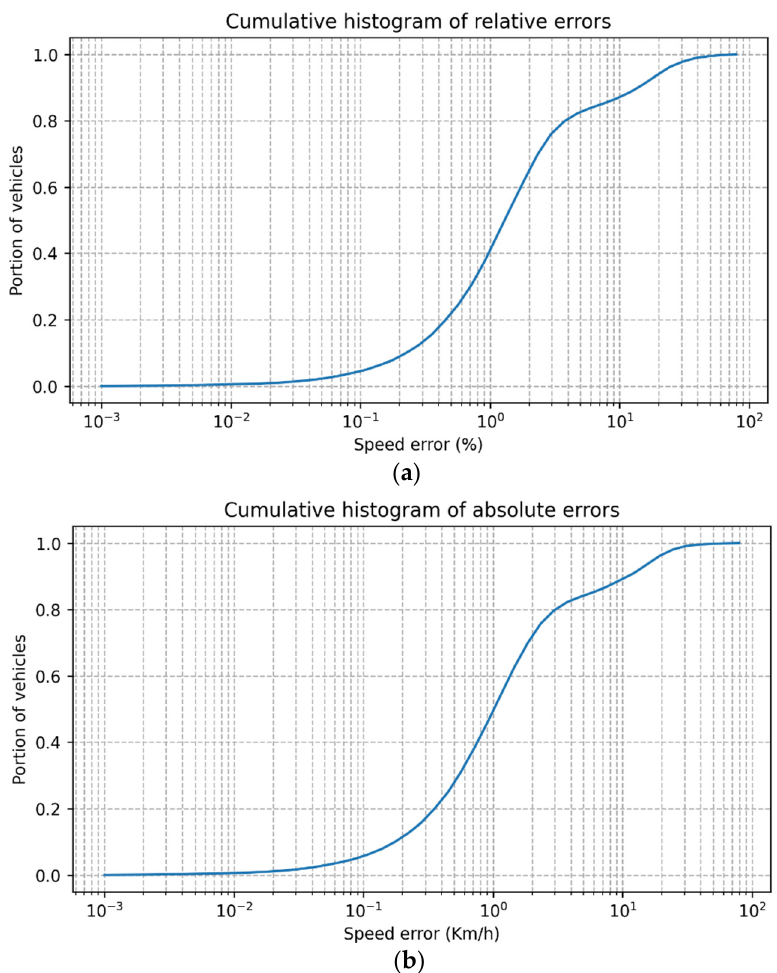
Figure 5. Cumulative histograms that show the distribution of the speed error (logarithmic scale) when compared to the ground truth: ( a ) plot of relative errors; ( b ) plot of absolute errors.